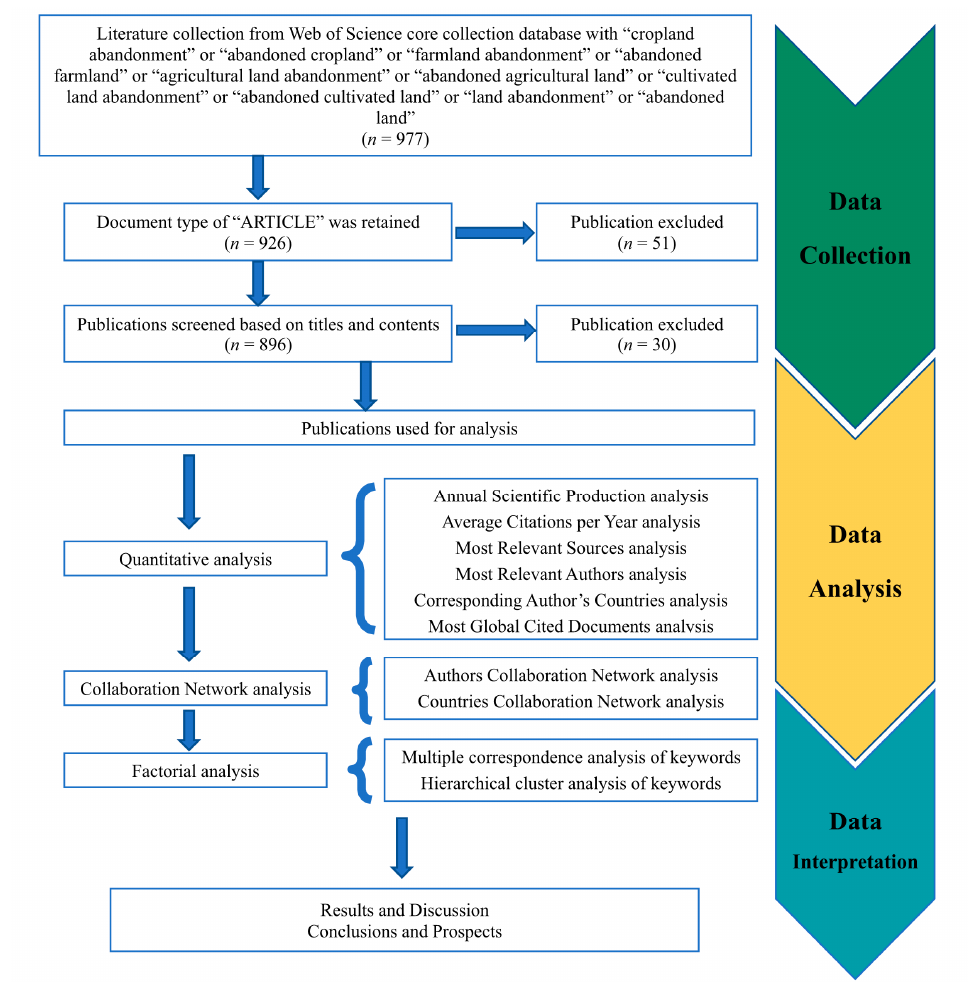
Figure 1. Technical f low of the applied bibliometrics approach.